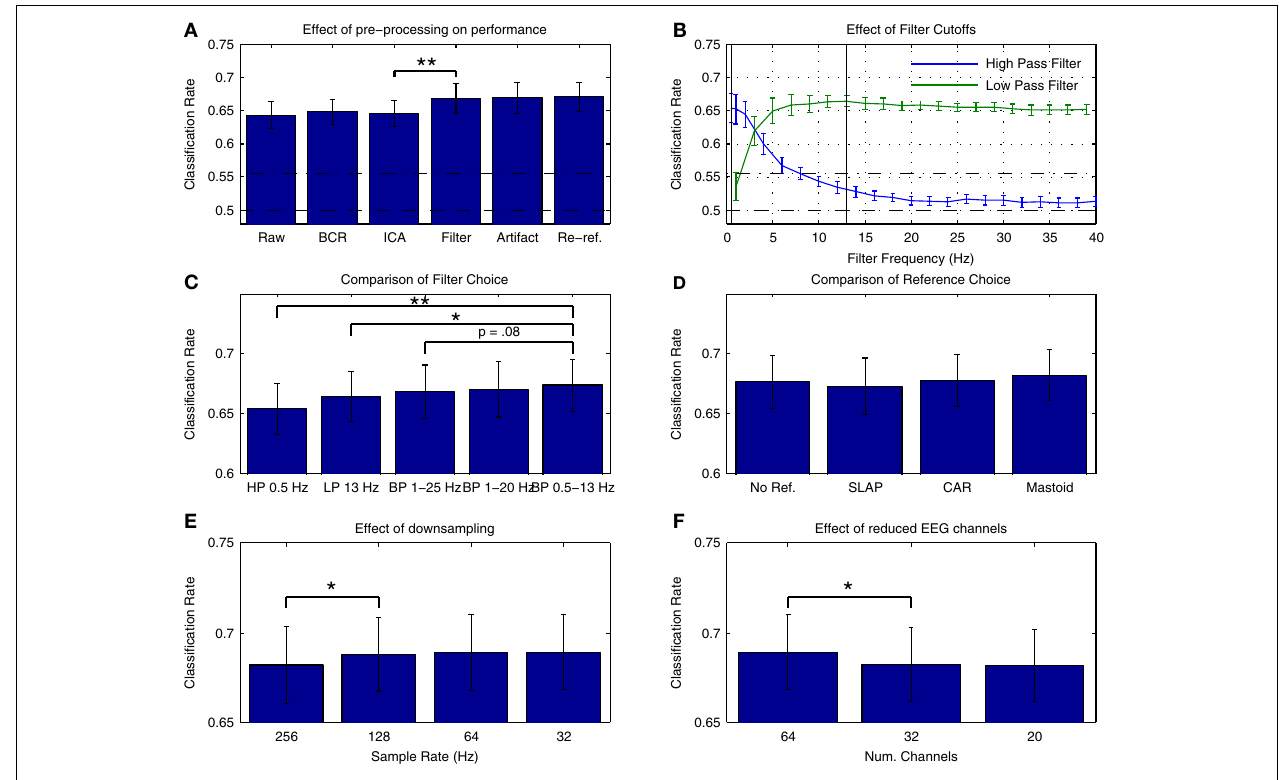
FIGURE 3 | Effects of preprocessing on cross-validation performance for Dataset 1. (A) Comparison of average cross-validation rates across subsequent stages of preprocessing. Individual participant’s data were used to train a linear logistic regression classifier following each of